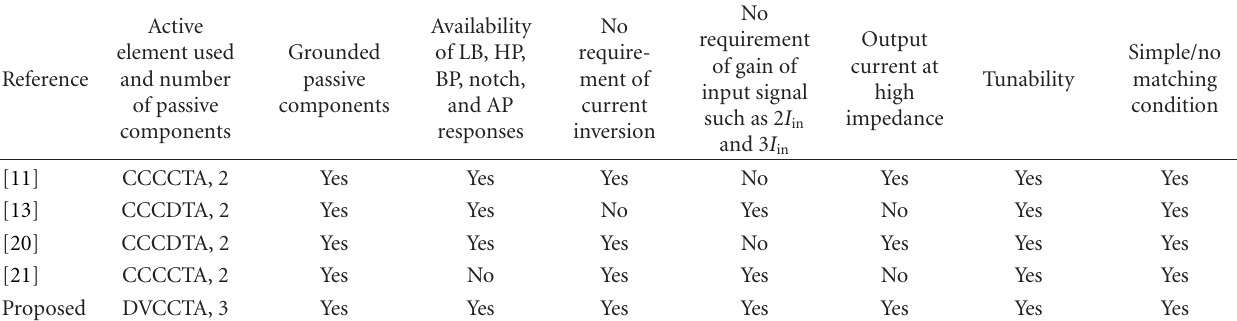
Table 5: Comparative study of the available similar type of single-active-element-based CM filters.